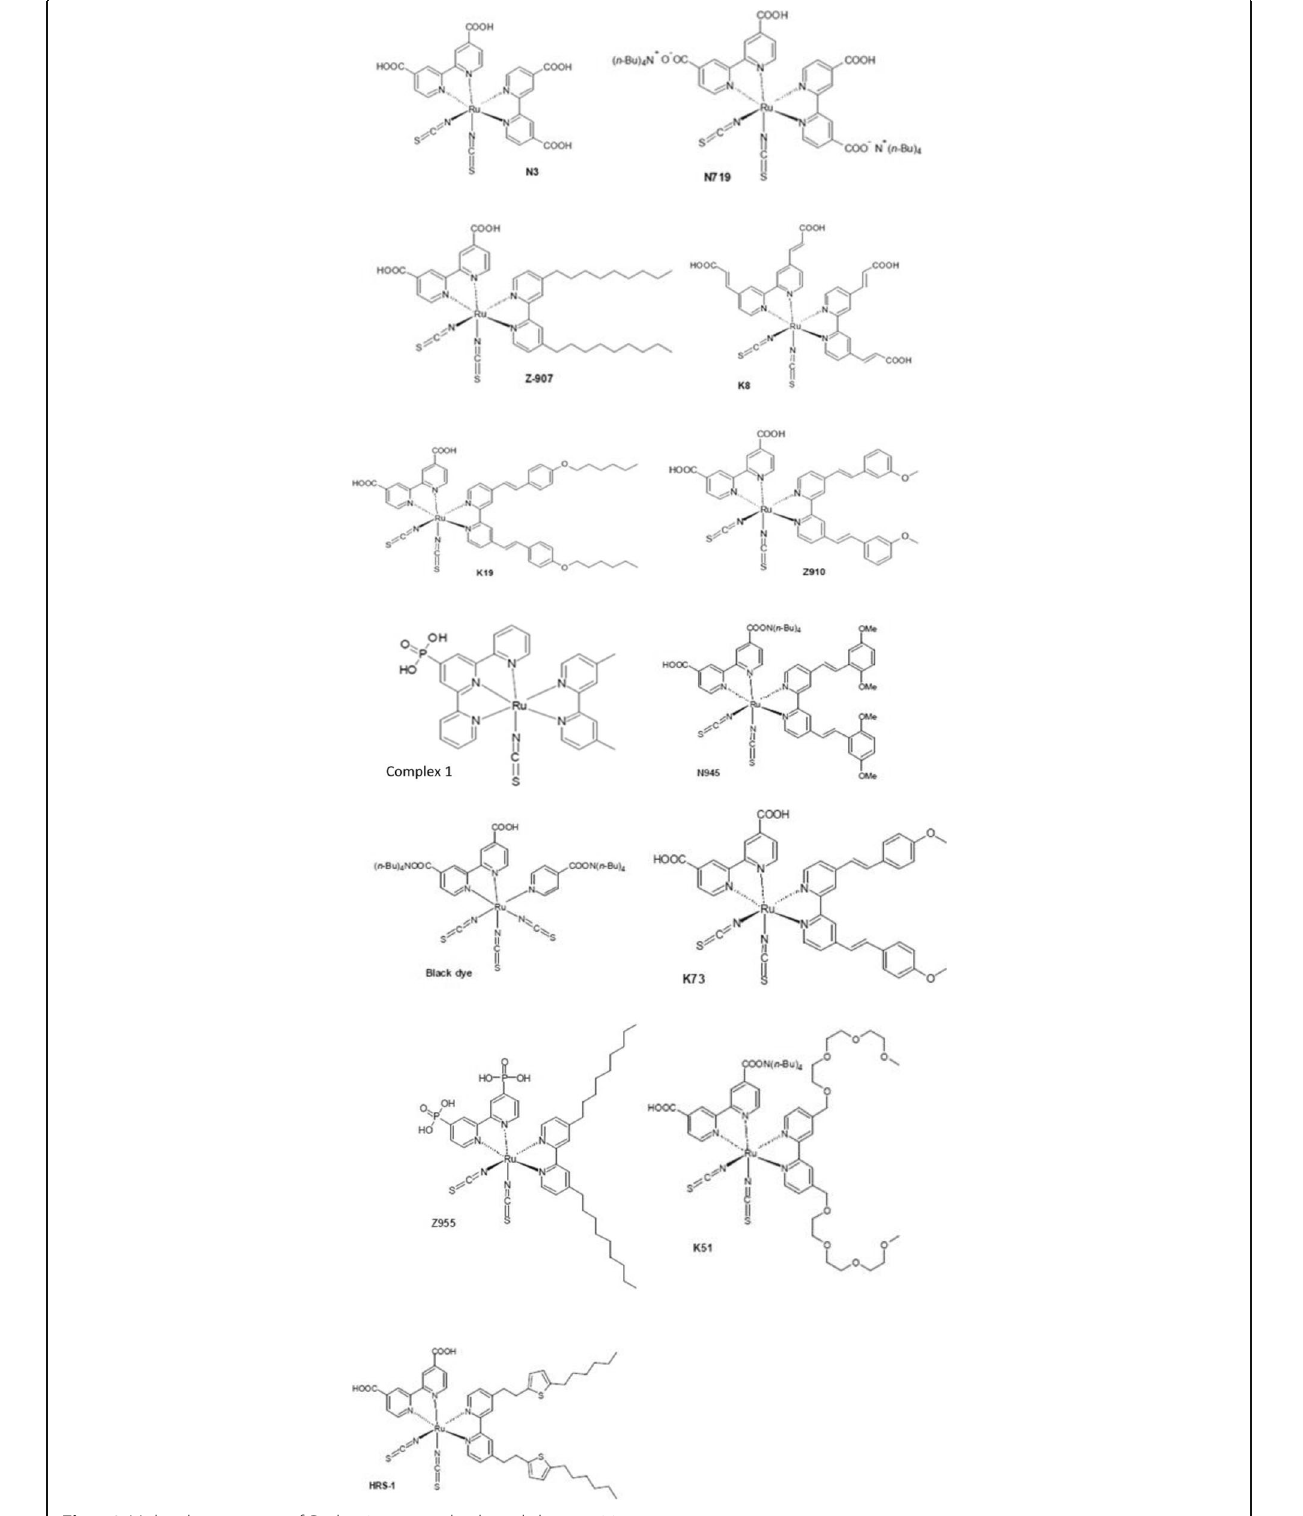
Fig. 12 Molecular structure of Ruthenium complex based dye